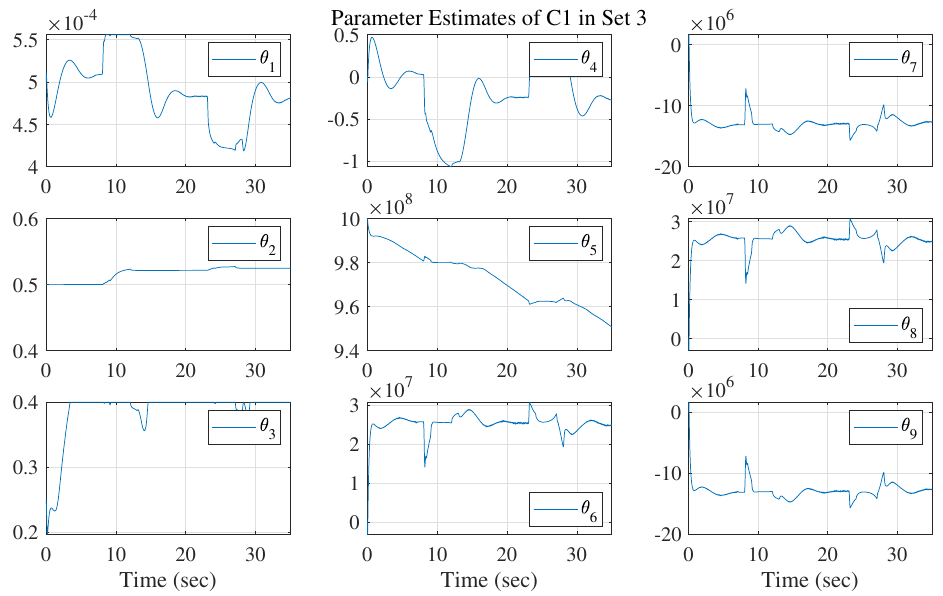
Figure 11. Parameter estimation results of C1 in Set 3. Then, the synchronization performances are compared according to the calculated rotational angle α of the crossbeam. The rotational angles of C1, C2, and C3 in Set 1, where the inclined angle Θ of the entire lifting gantry is set to zero, are illustrated in Figure 12. Under such ideal working conditions, the loads act equally on the dual cylinders. As expected, the three control schemes are all able to regulate the angles to zero after quick transient processes, and the only difference is that C1 and C2 are slightly quicker. However, when it comes to the unbalanced load conditions, i.e., in Set 2 and Set 3 with the inclined angle Θ = 0.5 rad, 1 rad, the synchronization performances become distinct, as shown in Figures 13 and 14, respectively. The resulting angles of C1 and C2 are able to converge to very small values after quick transient processes. This comes from the effect of the proposed thrust allocation applied in both C1 and C2. Due to the allocation, the remaining forces pushing the rotational motion, as defined in (17), can be kept small enough, such that the large stiffness of the connections between the crossbeam and guide lines acts as a large proportional feedback to regulate the rotational angle within a very small range. In contrast, without the thrust allocation, the resulting rotational angle of C3 becomes much larger when unbalanced loads act on the dual cylinders. To confirm the synchronization performance, the proposed thrust allocation scheme works well in regulating the unbalanced loads on the dual cylinders and thus leads to a high level of synchronization compared with the commonly used